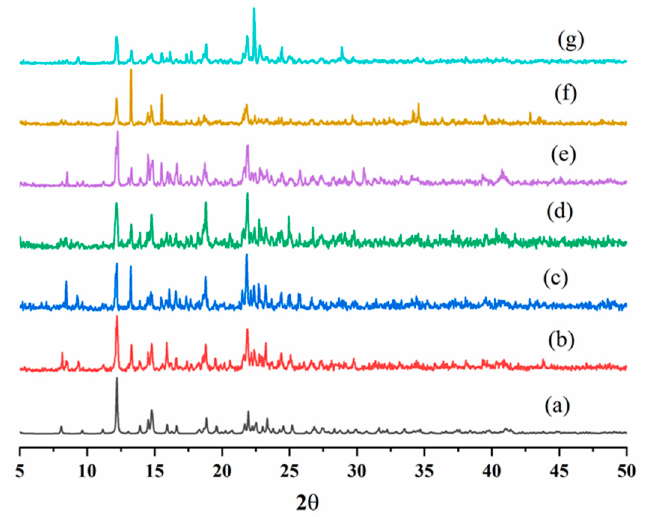
Figure 10. PXRD patterns before and after treatments with Fe 3+ ions for 7 . ( a ) Simulated, ( b ) experi- mental, ( c ) 1st cycle, ( d ) 2nd cycle, ( e ) 3rd cycle, ( f ) 4th cycle, and ( g ) 5th cycle.